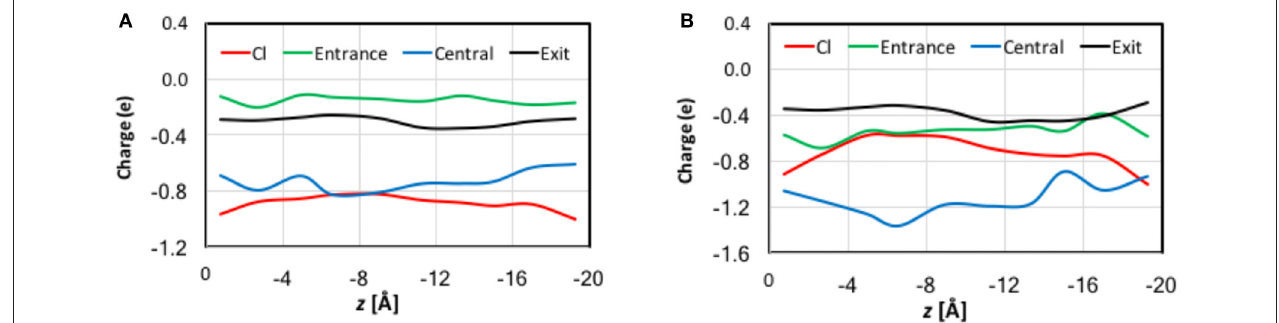
FIGURE 7 | QM charges for the Cl − ion and the total charges for the entrance, central, and exit cohorts of residue functional groups against the reaction coordinate z for representative geometries in QM/MM umbrella sampling simulations. Note that to assist better visualization, we have divided the reaction pathway into 10 sections (each of 2 Å long) and collected the average charges over each section. See the text for the cohort definitions. (A) Natural charges. (B) Löwdin charges.